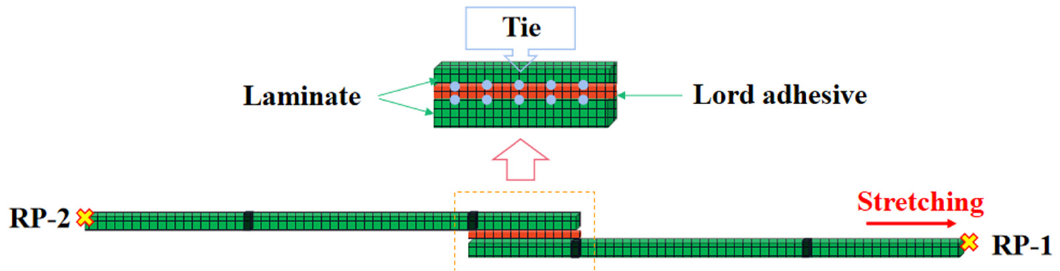
Figure 5. Simulation set-up.